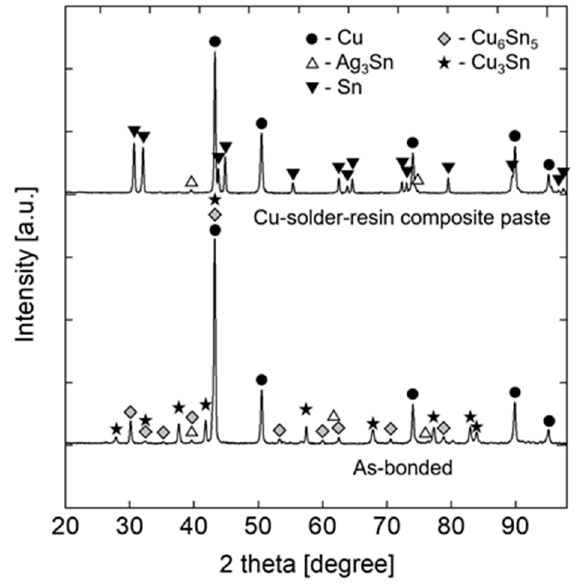
Figure 4. XRD patterns of the Cu-solder-resin composite paste and the as-bonded TLPS bonding layer.